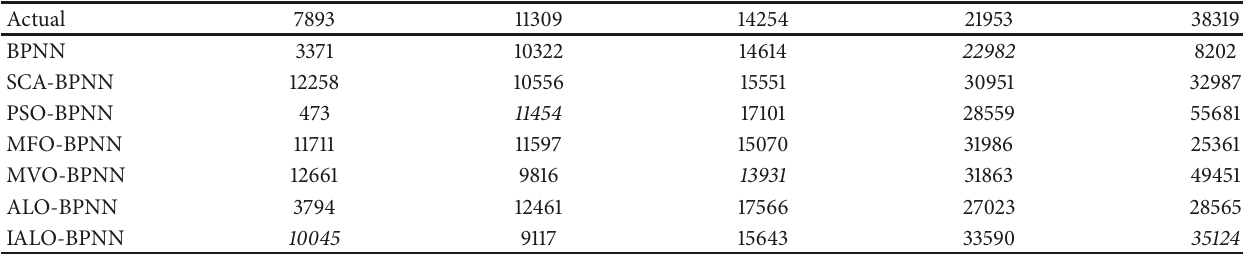
Table 3: Predicting the number of influenza patients.